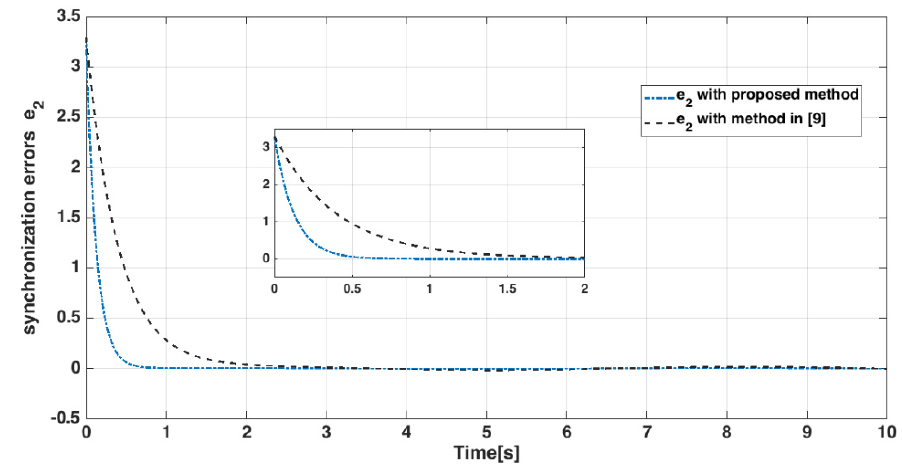
Figure 15. State error 𝒆 𝟐 of master-slave systems.